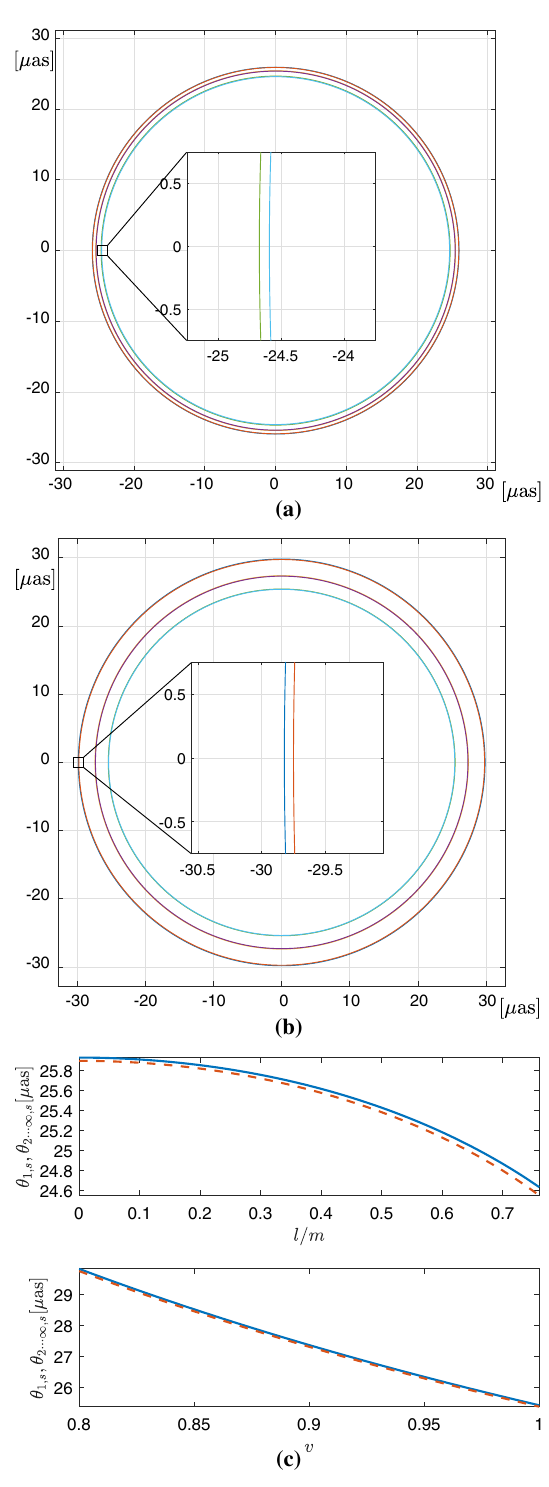
Fig. 4 a Relativistic Einstein rings assuming that the SgrA* BH is an Hayward BH for v = 1 and l / m = 0 , 1 / 2 , 3 / 4 from outer to inner circle. Zoom-in: partially resolved θ 1 , s and θ 2 ···∞ , s . b Relativistic Einstein rings for l / m = 1 / 2 and v = 1 , 0 . 9 , 0 . 8 from inner to outer respectively. Zoom-in: Partically resolved Einstein rings for v = 0 . 8.